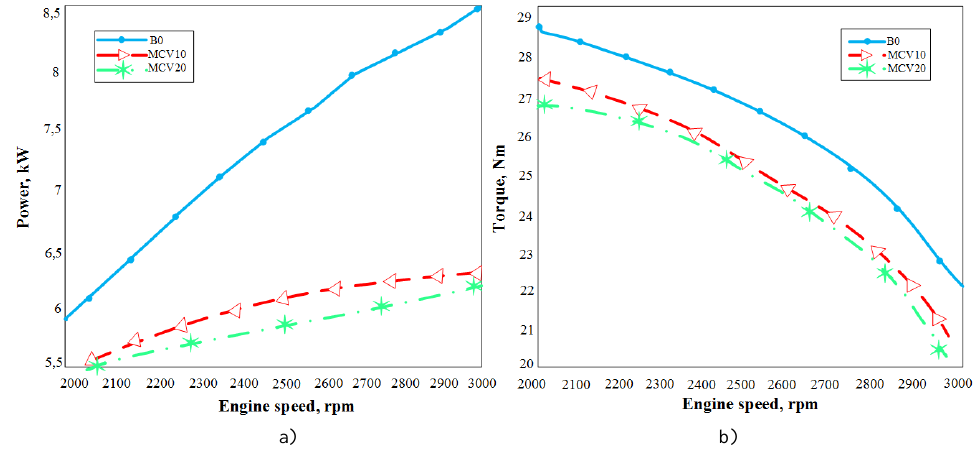
Fig. 9. Power (a) and torque (b) of engine with MCV biodiesel blends at